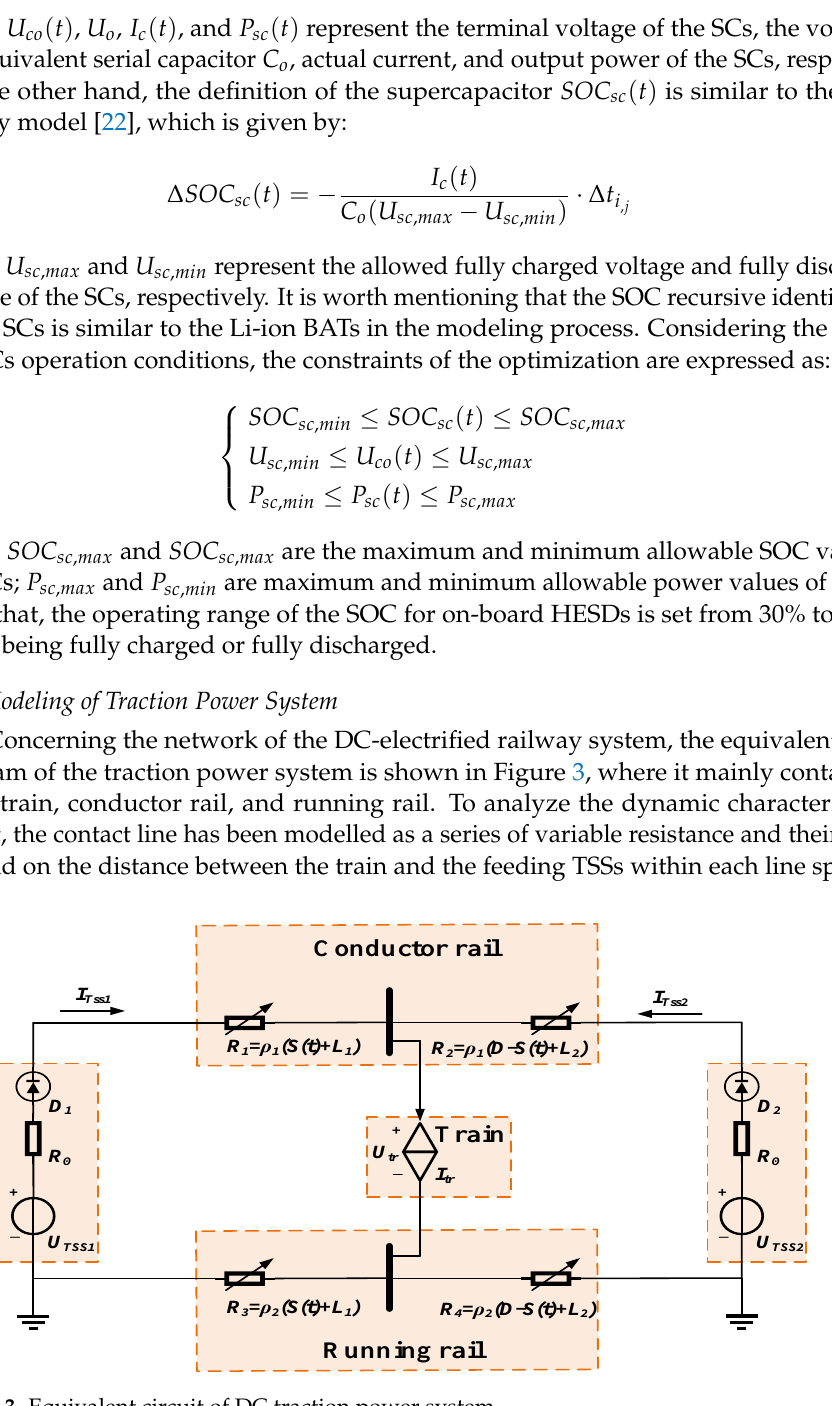
Figure 3. Equivalent circuit of DC traction power